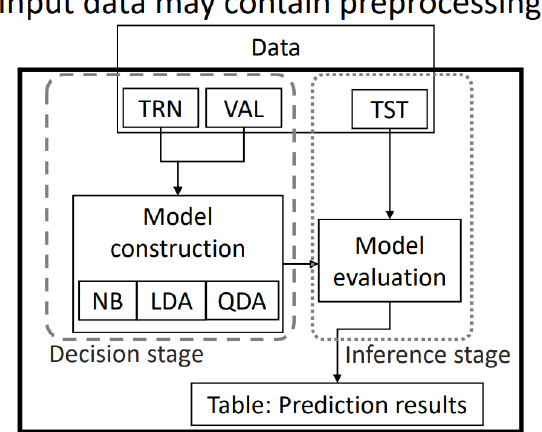
Figure 4. Creation of the classification model. The decision and inference stages of machine learning can be observed in the creation of classification models.